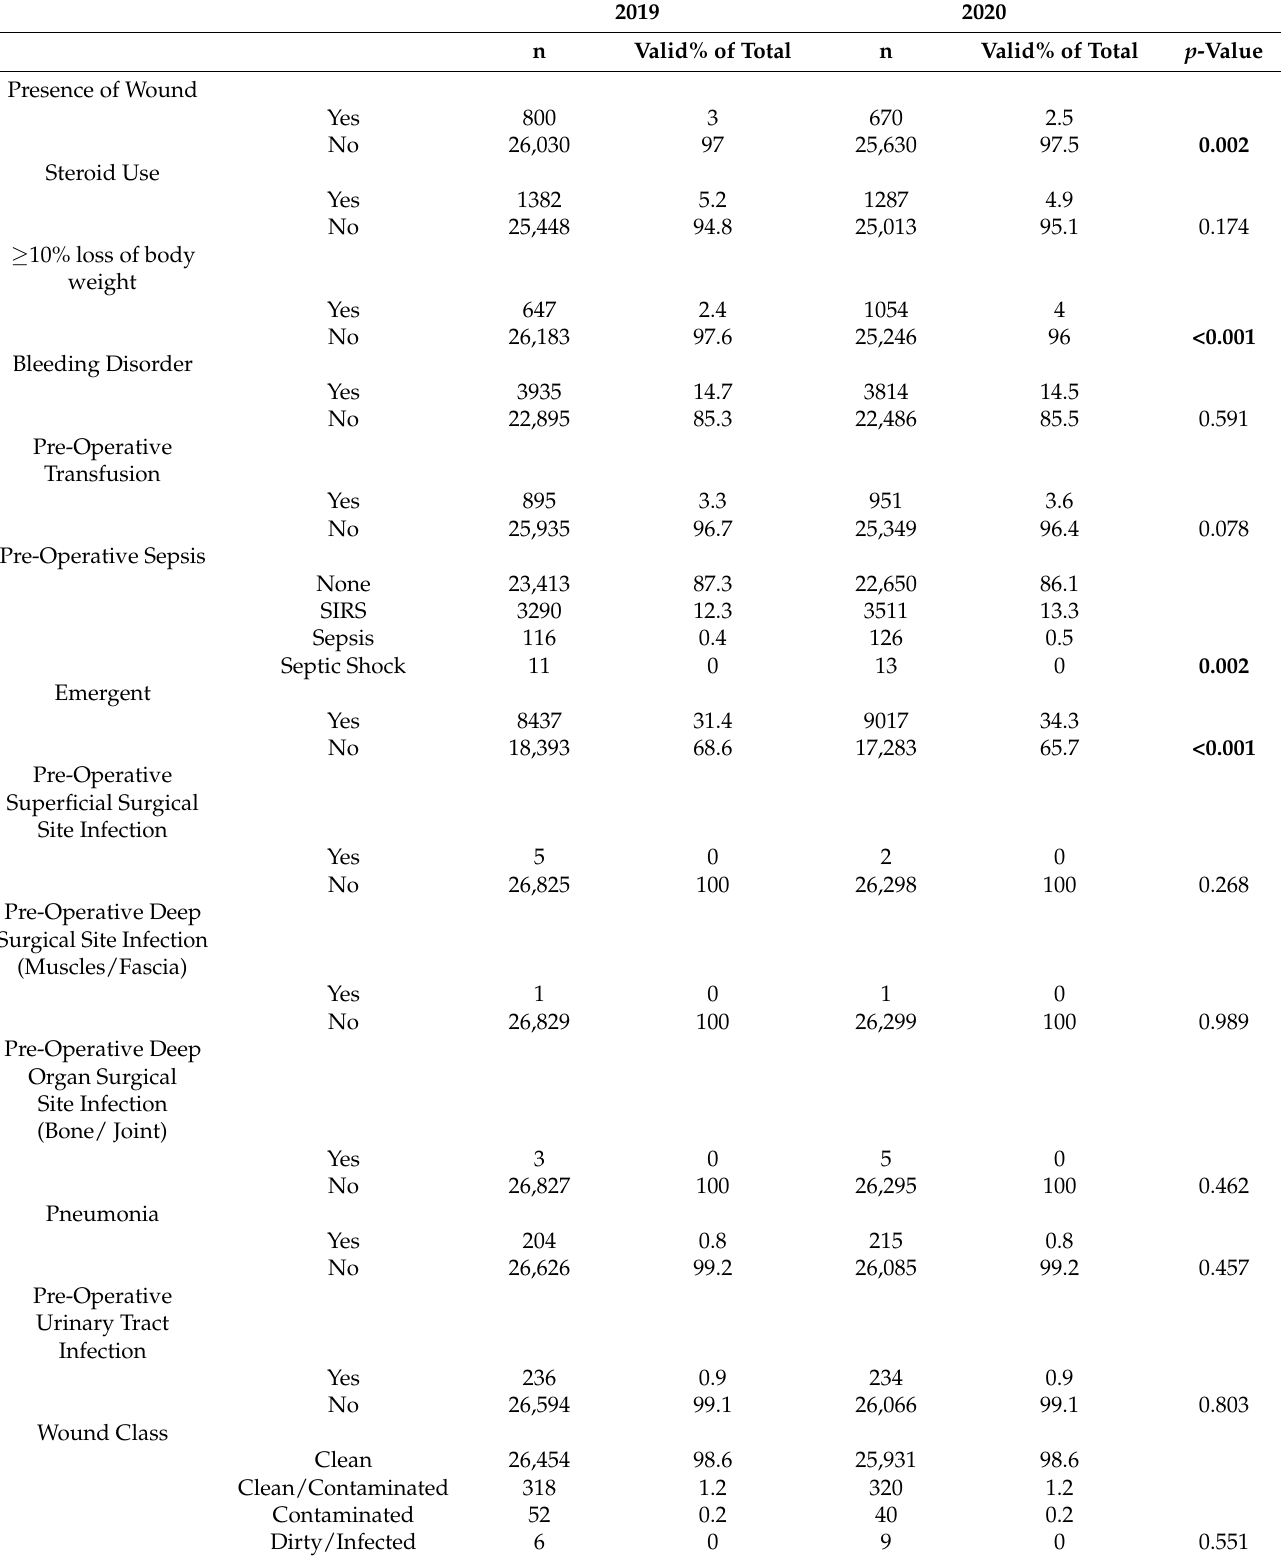
Cross Table Year of Diagnosis and Preoperative and Intraoperative Patient Characteristics with